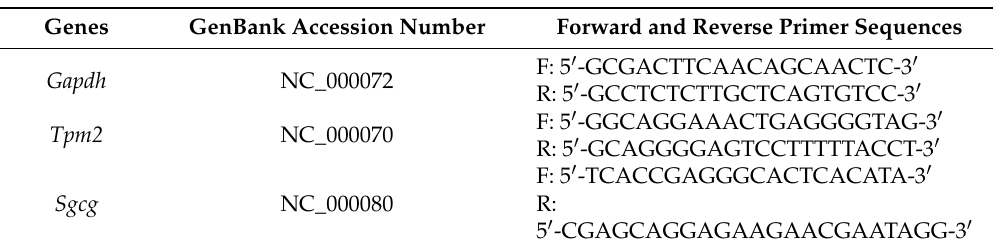
Table 2. Reverse transcription-quantitative PCR primer sequences. Glyceraldehyde-3-phosphate